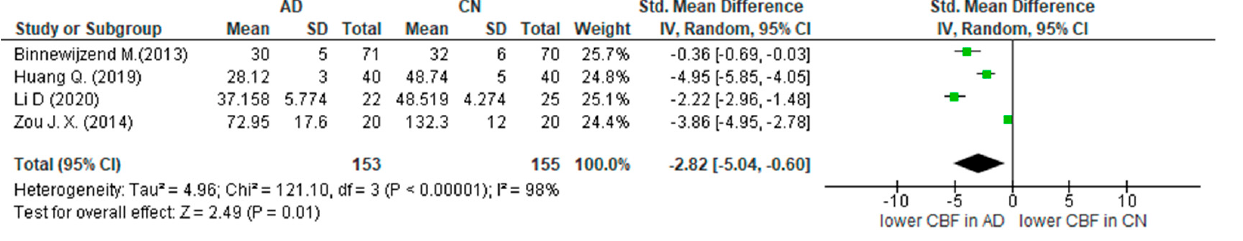
Figure 3. Hippocampus: Alzheimer dementia vs. cognitively normal (Binnewijzend M. (2013) [38], Huang Q. (2019) [47], Li D. (2020) [50], Zou J.X. (2014) [58]).